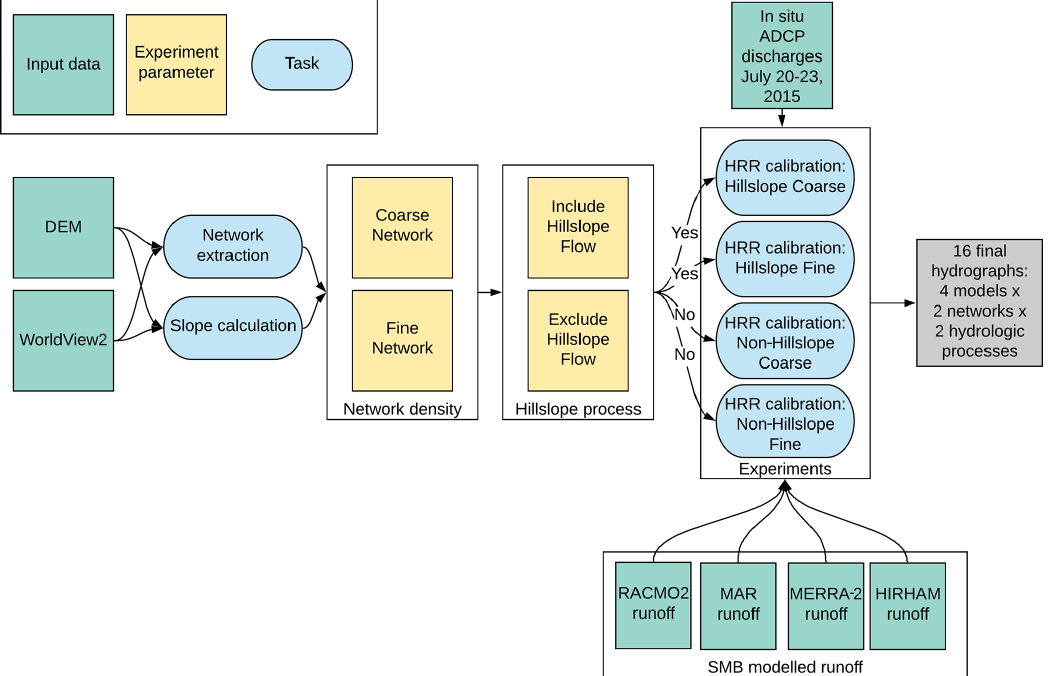
Figure 1. Schematic diagram of our experimental design and modeling procedure. Hillslope river routing (HRR) model inputs, processes, and outputs are labeled. This workflow yields 16 independent hydrographs by considering fine vs. coarse supraglacial channel network densities and inclusion vs. exclusion of hillslopes in addition to open-channel